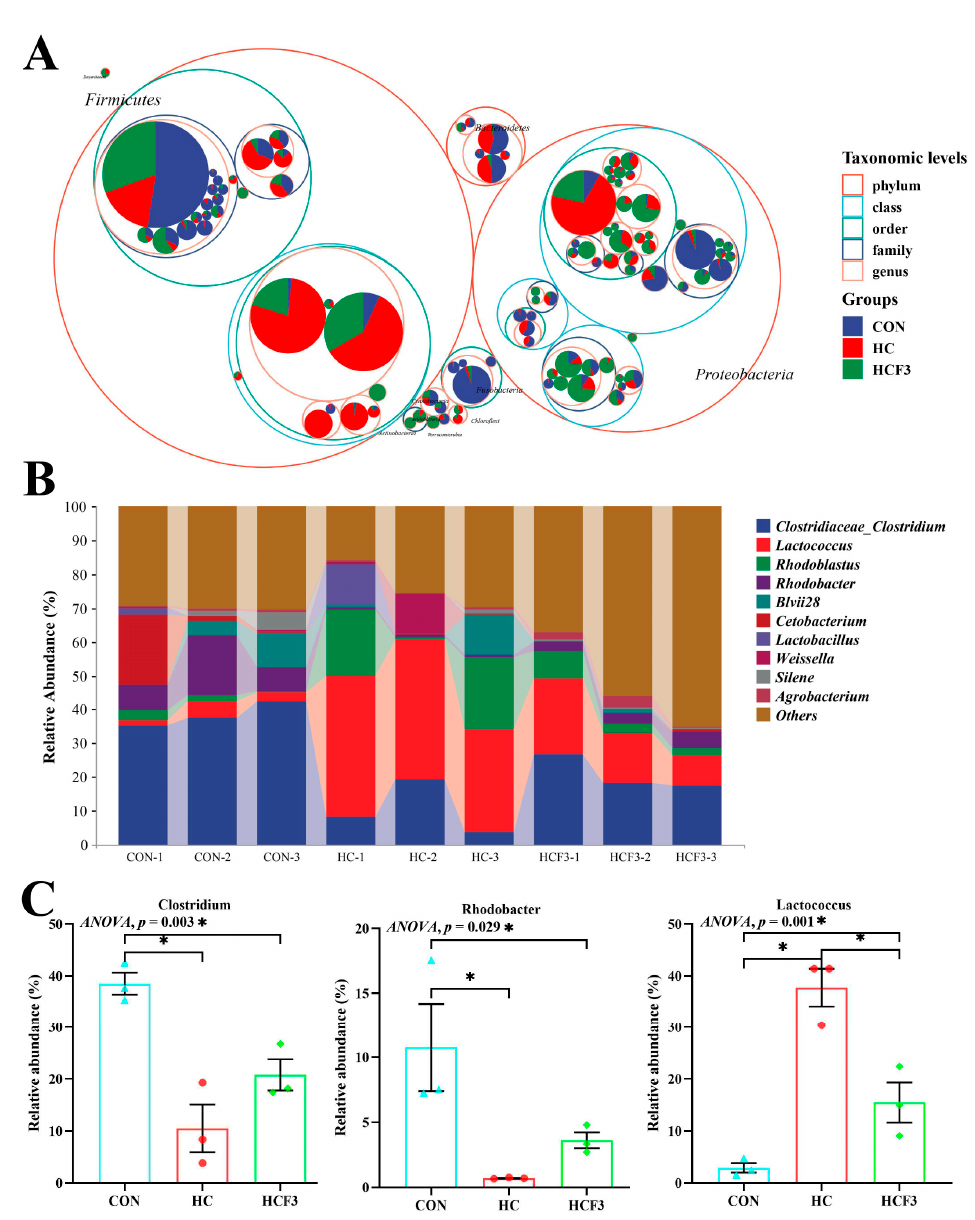
Figure 8. Effects of dietary mulberry leaf flavonoids on the intestinal microbial composition of rice field eel ( Monopterus albus ) fed high-carbohydrate diets. ( A ) Classification hierarchy tree diagram (The largest circle represents phylum level, and the decreasing circle represents class, order, family, genus and species in descending order). ( B ) Species abundance at the genus level (Top 10), ( C ) showing significant variations of the relative abundance of intestinal microbiota at the genus level. * indicates a significant difference between groups ( p < 0.05).